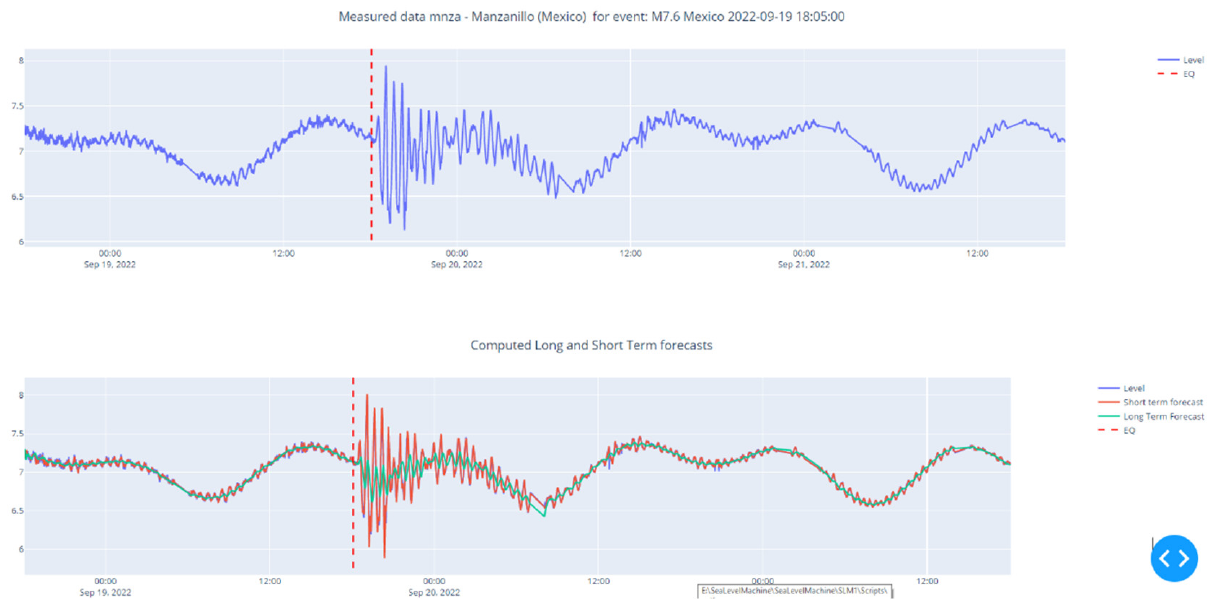
Figure A3. Screenshot of the SLM web site with the analysis of one particular signal measured for a specific event.